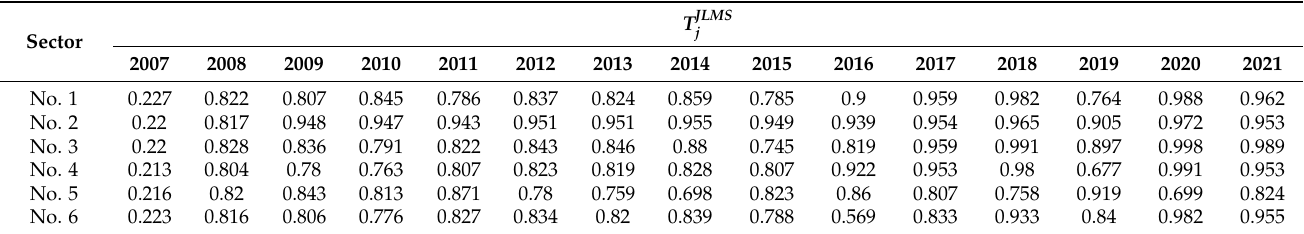
Table 6. Efficiency assessment values (author’s results). T JLMS j